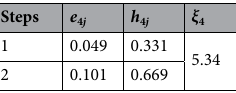
Table 6. Section 2 calculation parameters.